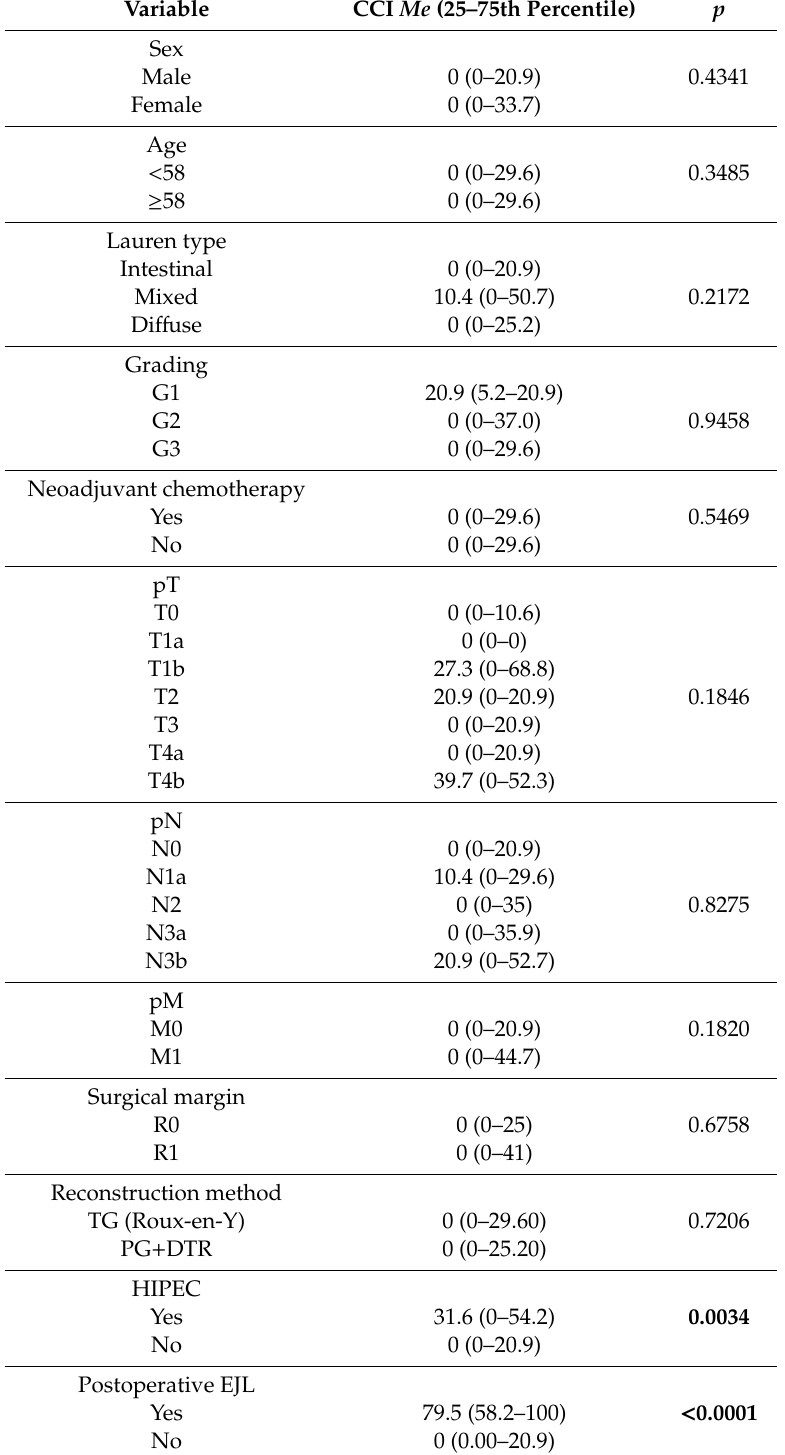
Table 3. Comparison of CCI values depending on demographic, clinical and pathological